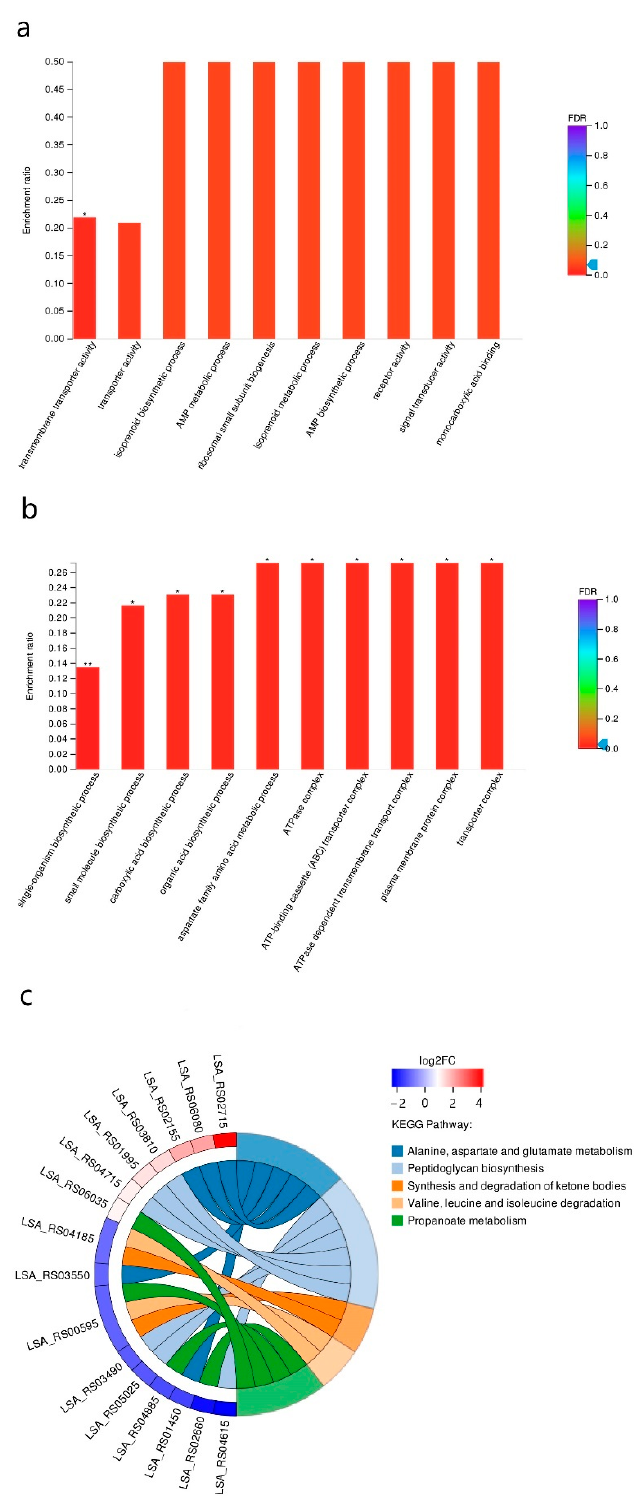
Figure 6. GO enrichment analysis of the total differentially expressed genes ( a ) and of the upregulated genes and the significantly enriched terms ( b ). The five most enriched KEGG pathways and the corresponding differentially expressed genes ( c ). (** p < 0.01, * p <